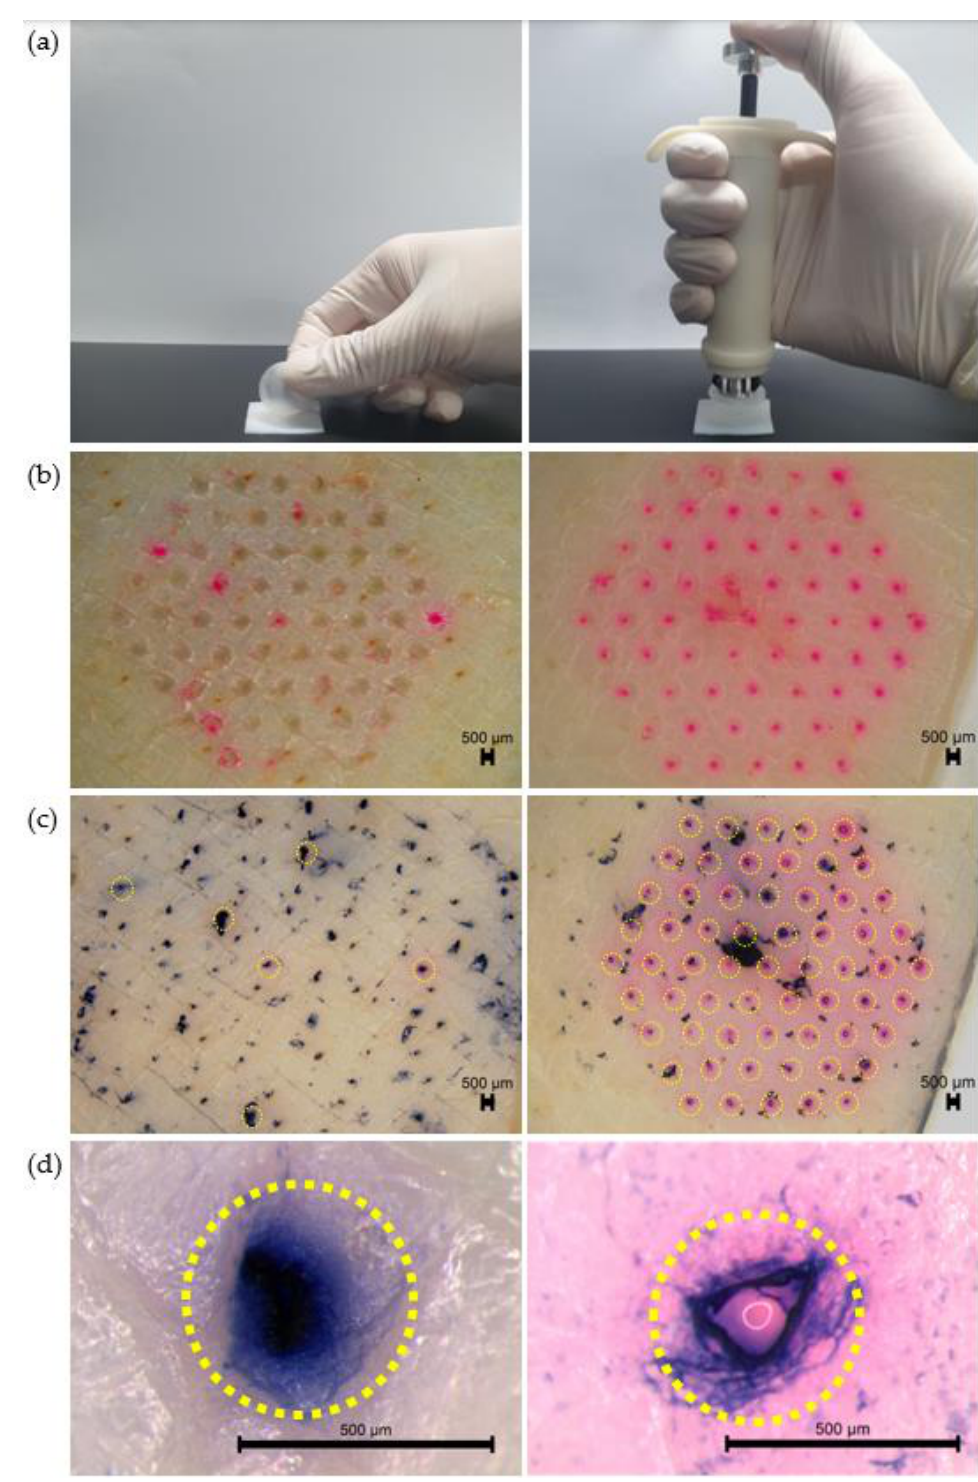
Figure 3. Analysis of the skin penetration of TA-DMNs applied using a shooting device or finger force: ( a ) TA-DMN patches application performed using finger force or a shooting device; ( b ) porcine skin inserted with Rhodamine B-loaded TA-DMNs using a finger force or a shooting device; ( c ) verification of porcine skin penetration by trypan blue staining; ( d ) enlarged images of perforated porcine skin. The black bar represents 500 µ